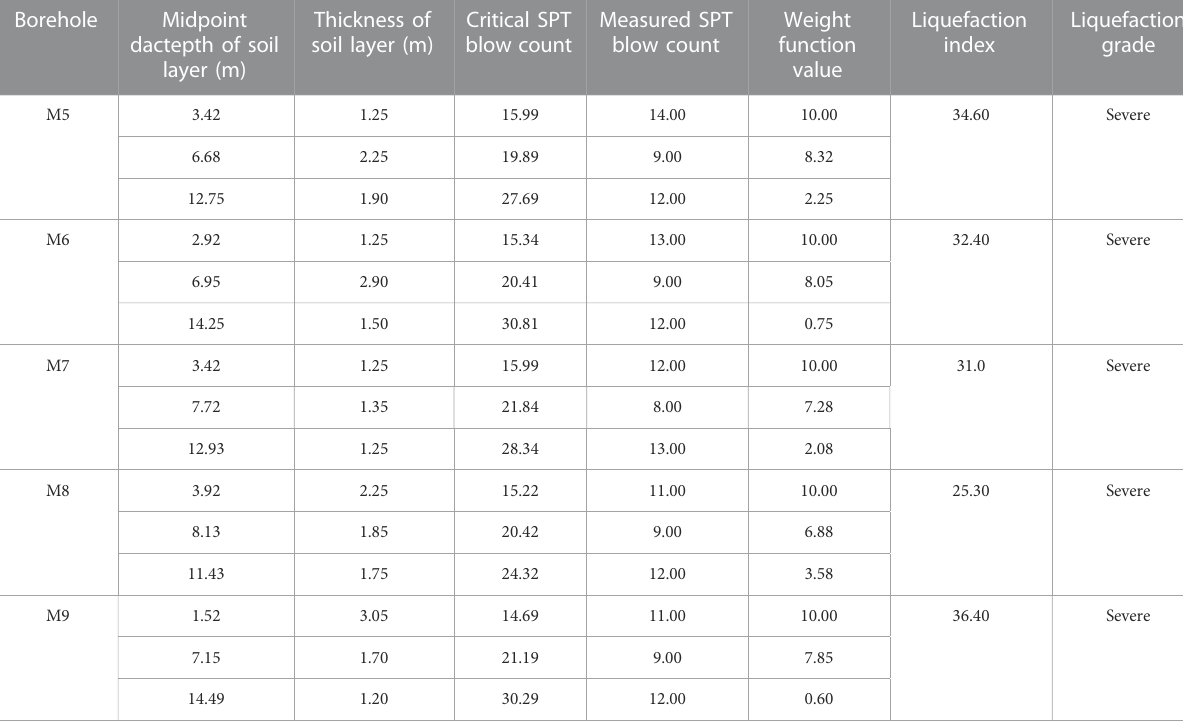
TABLE 4 Liquefaction susceptibility of the nickel-cobalt ore port site by